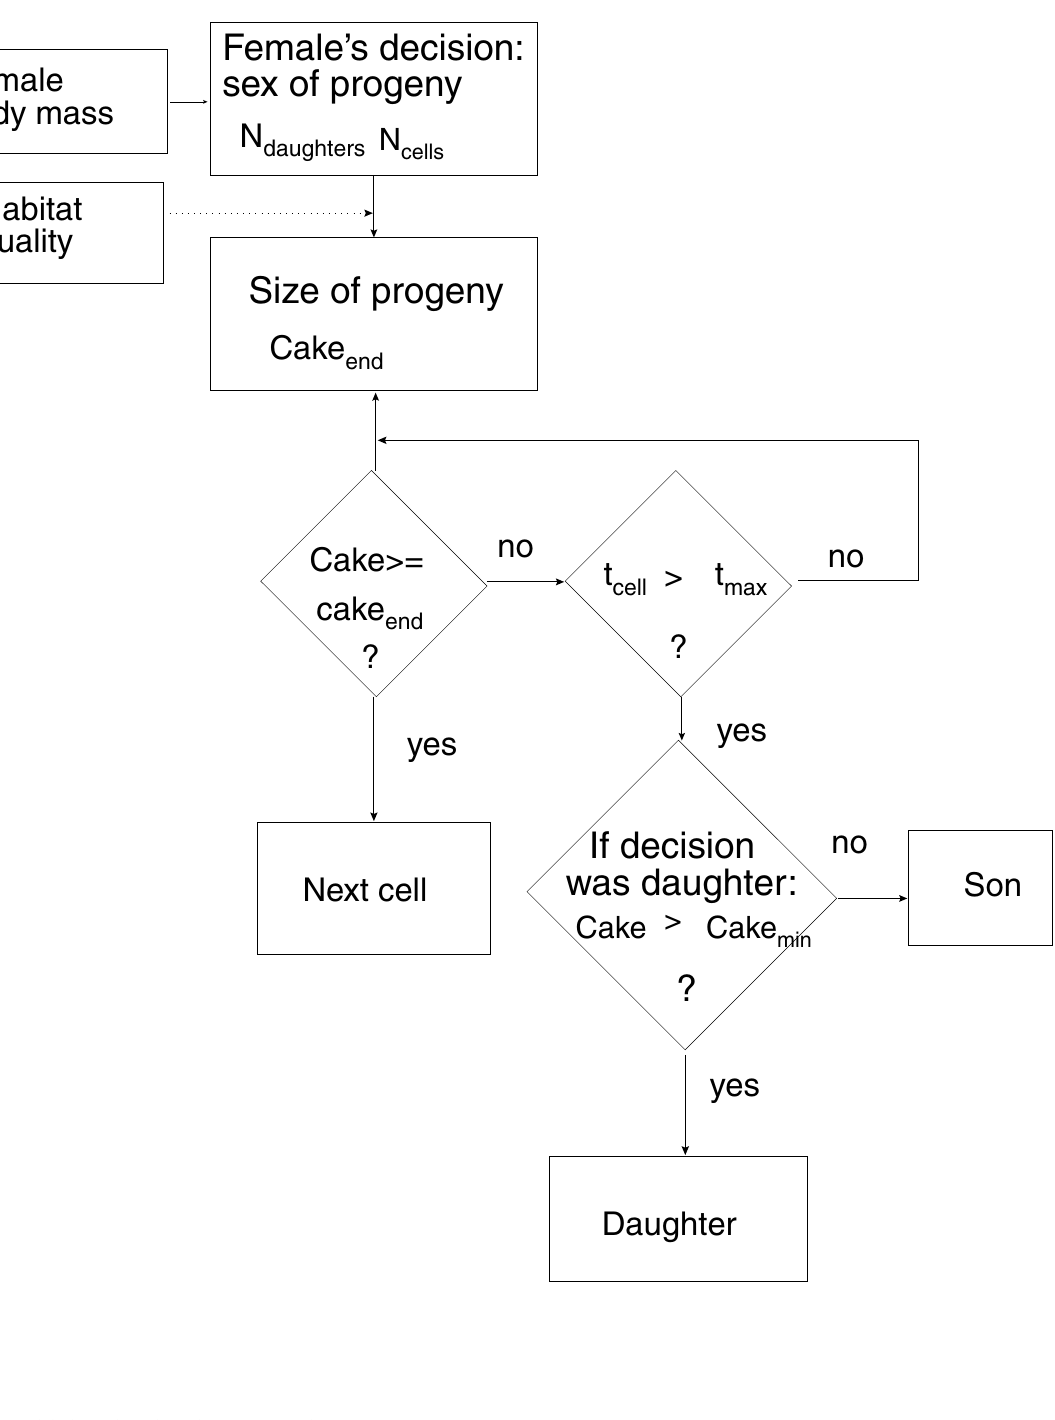
Fig. 1. Model algorithm describing maternal